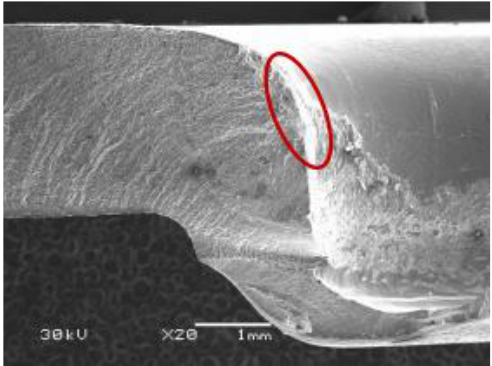
Figure 16. Cross-sectional fatigue crack of AA5052 alloy in SPFC-AA joint.